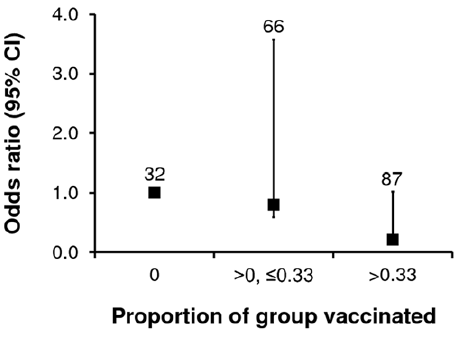
Figure 2. Decreasing risk of an unvaccinated badger cub testing positive to a triple diagnostic test for M.bovis infection as the proportion of vaccinated badgers in its social group increases. The number of cubs within each category is shown.